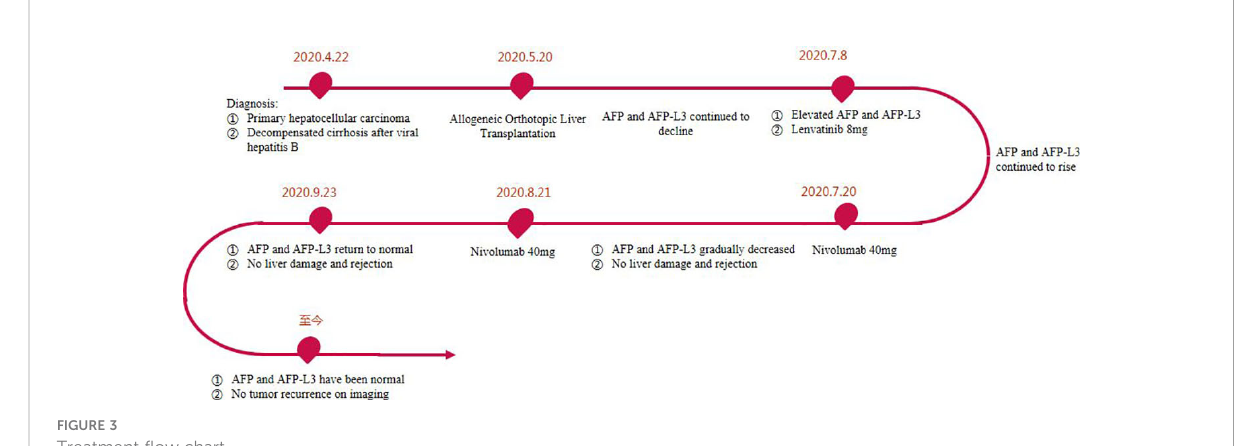
FIGURE 3 Treatment fl ow